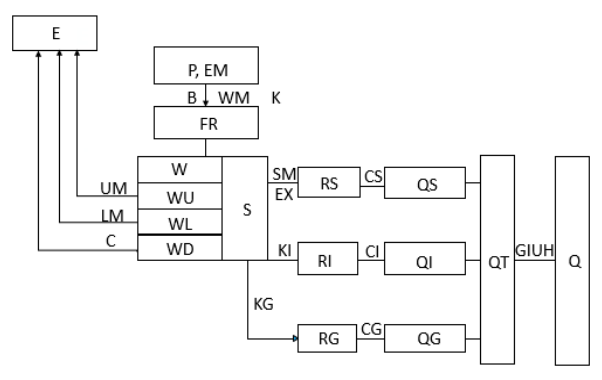
Figure 2. The structure of modified Xin’anjiang (XAJ) model couple with geomorphologic instantaneous unit hydrograph (GIUH) in this study (GIUH is supposed to replace the former method to calculate the stream flow routing), and the explanation of all the items in the figure.